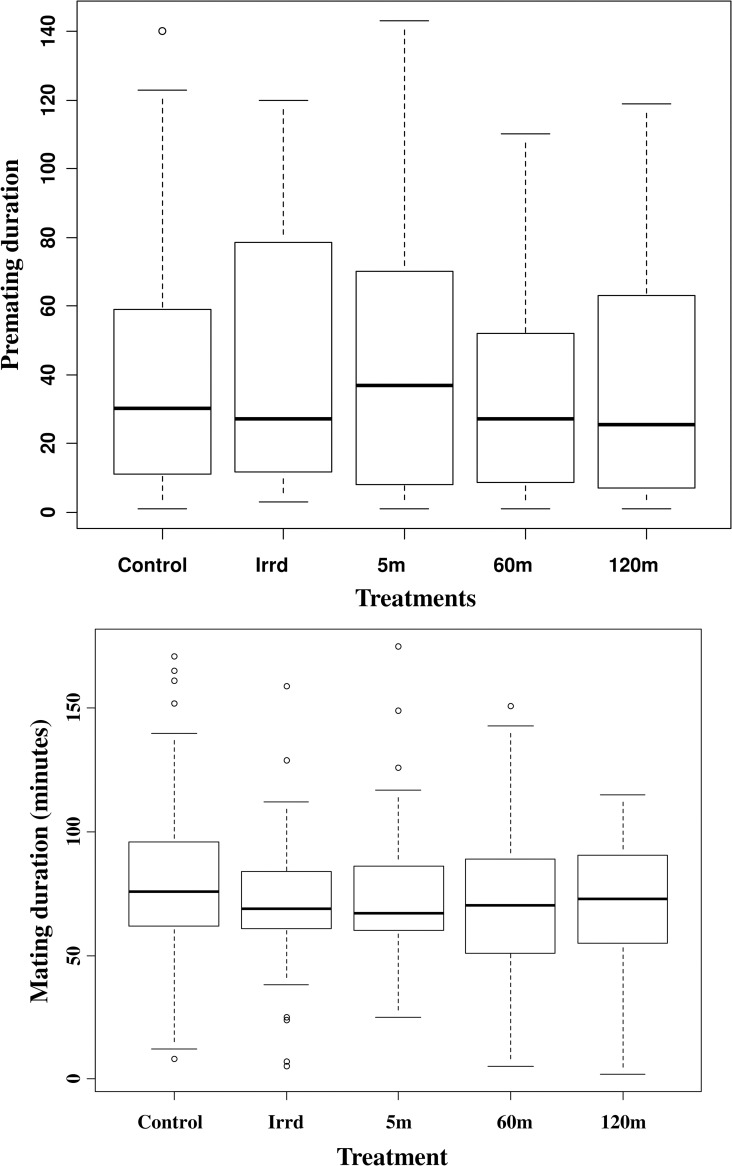
Impact of the release process through the BSITM on male premating period (a) and mating duration (b). Seven-day old males from different treatment (only irradiated (Irrd) and irradiated males exposed to the release process for different durations (5, 60 and 120 minutes)) were released in field cage to compete with untreated colony males for mating with three-day old females for two hours. Couples were collected and mating competitiveness was calculated. Thirty flies from each group were used. (Premating period F = 1.549, df = 4,583, p = 0.1865, mating duration F = 1.34, df = 4,376, P = 0.2544). The graph represents the minimum, first quartile, median, third quartile and maximum for each treatment.